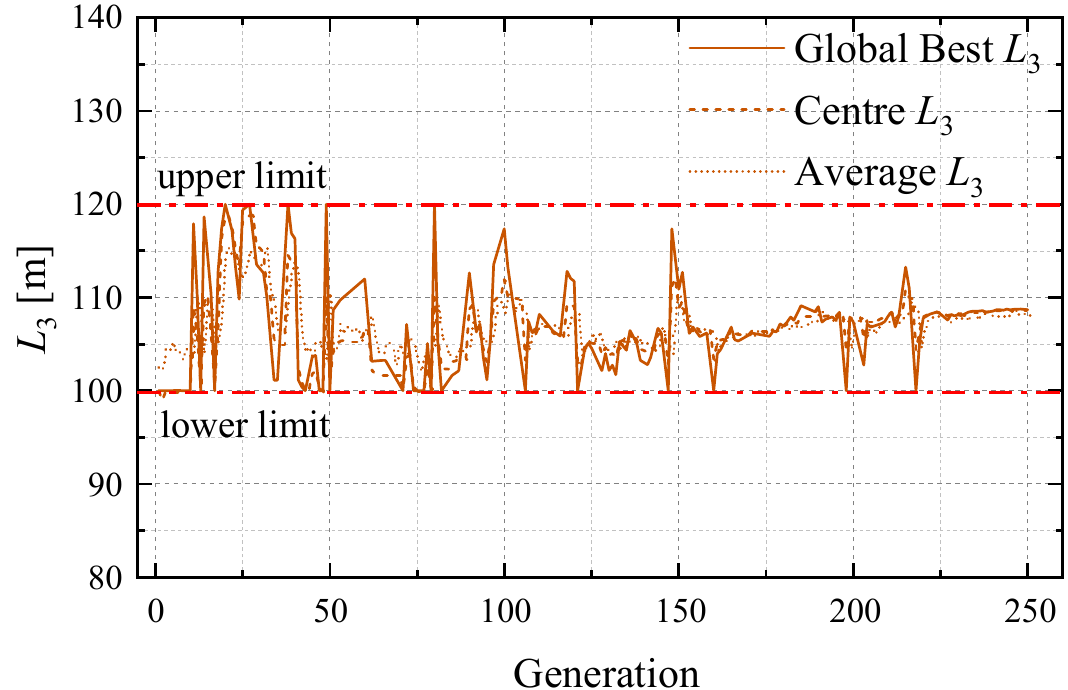
Figure 21. The convergence progress of length of central straight segment: L 3.